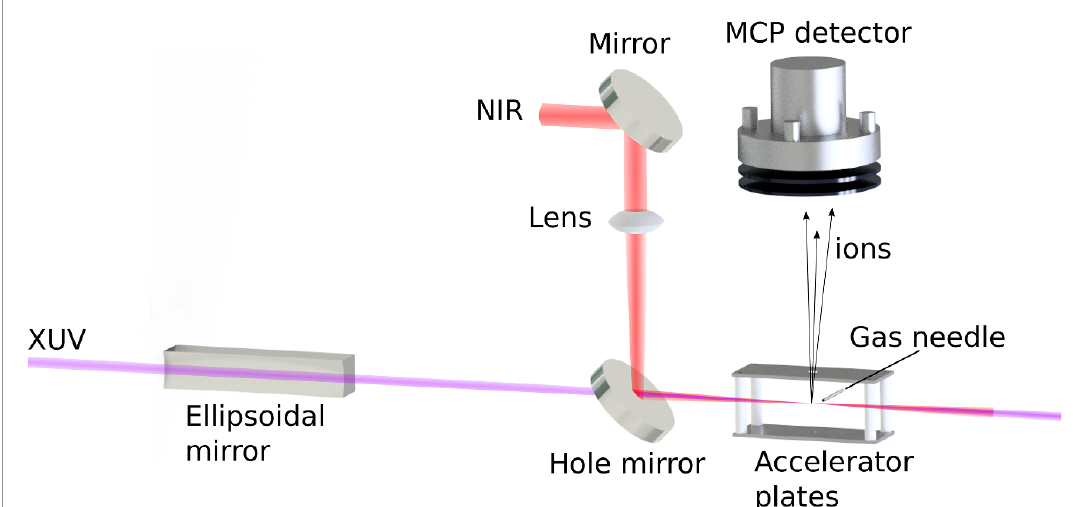
Figure 1. Experimental setup inside of the MAC end-station. The XUV and NIR beam are colinearly propagating via a hole mirror at 45 ◦ . Ions that are created in the interaction region are accelerated toward a time-of-flight mass spectrometer. The sample gas is delivered to the interaction region by an effusive gas